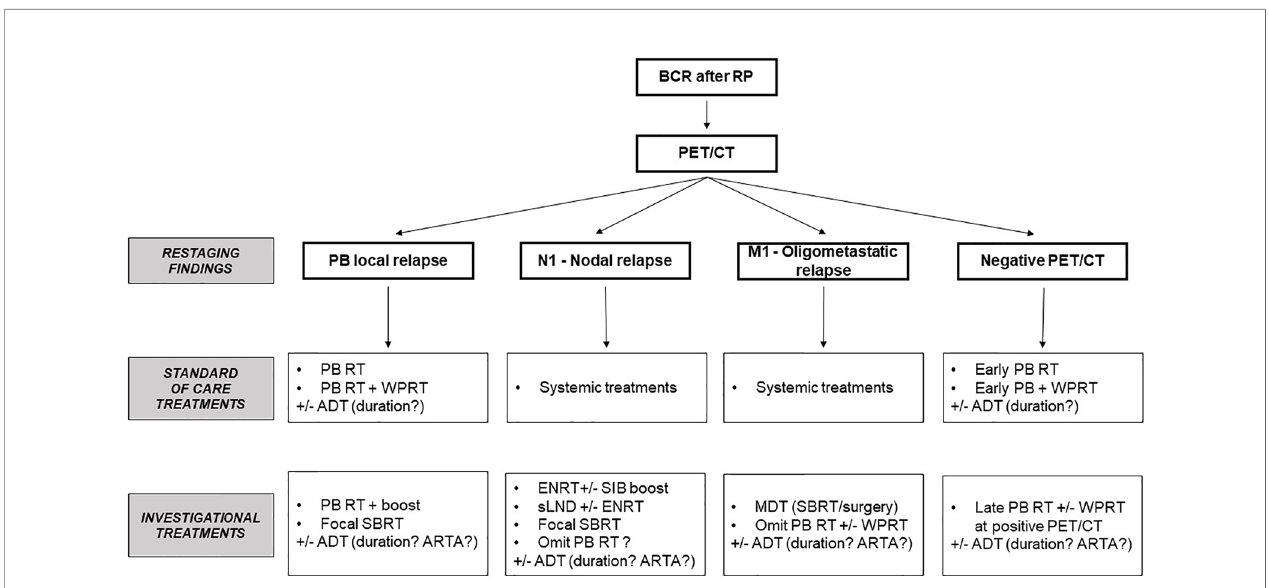
FIGURE 3 | Potential therapeutic options based on PET/CT restaging fi ndings. BCR, biochemical relapse; RP, radical prostatectomy; RT, radiotherapy; PB, prostate bed; WPRT, whole pelvic radiation therapy; SBRT, stereotactic body radiation therapy; ADT, androgen-deprivation therapy; ENRT, elective nodal radiotherapy; SIB, simultaneous integrated boost; sLND, salvage lymph node dissection; MDT, metastasis-directed therapy; ARTA, androgen receptor targeted agents.